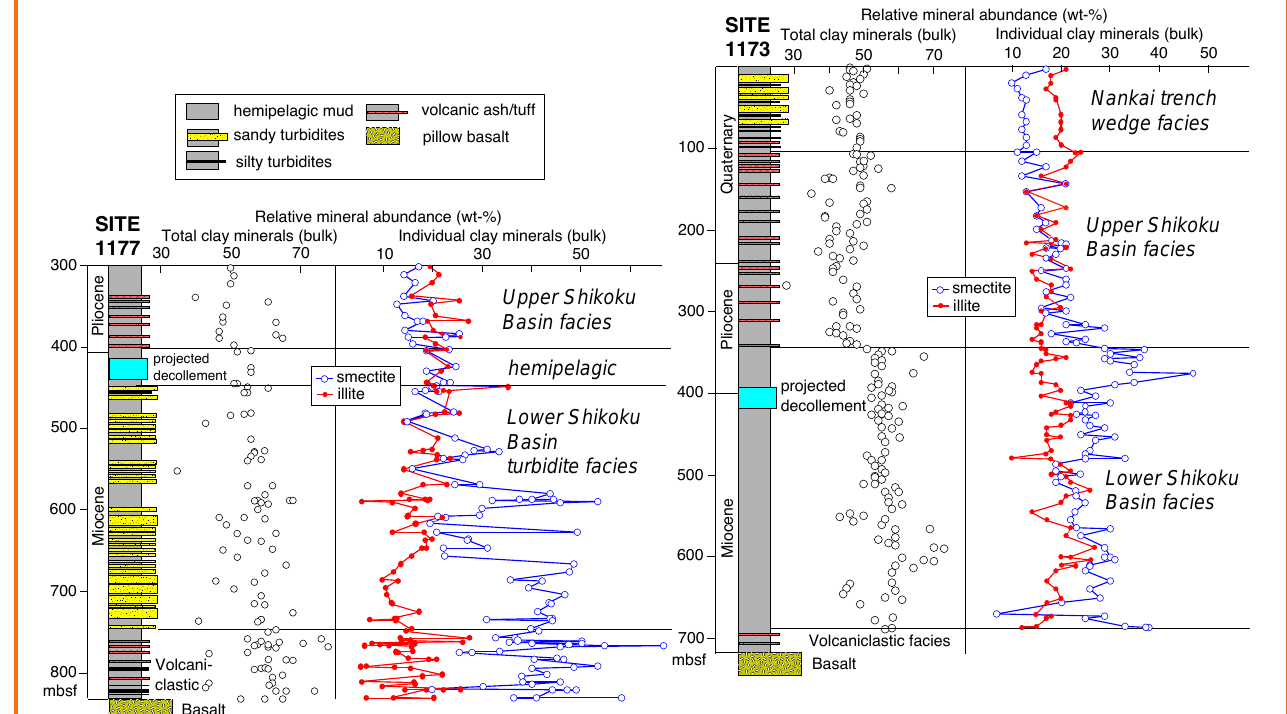
Figure 2. Stratigraphic columns for ODP Sites 1177 and 1173, Nankai Trough, with projected position of the frontal décollement in blue. Also shown are calculated values of total clay minerals (from bulk-powder x-ray diffraction) and estimated weight percentages of smectite and illite in bulk mudstone (from clay-size XRD). See Steurer and Underwood (2003) for XRD